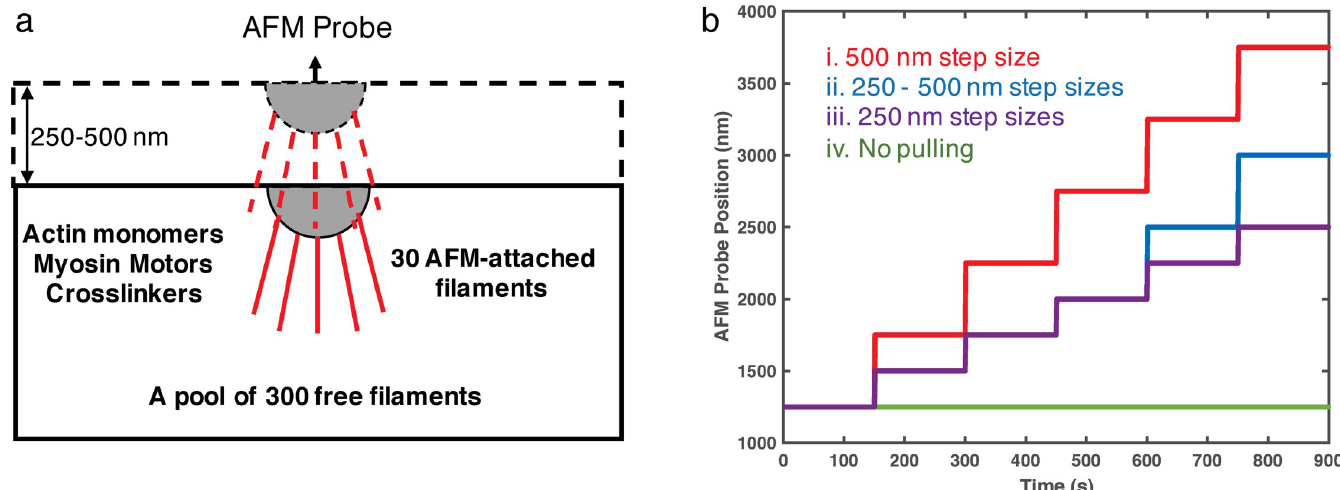
Fig 2. (a) A sketch of the simulation setup. The simulation box is 3 μ m in x and y directions, and the initial height (z-direction) is 1.25 μ m. The simulation box contains 300 free actin filaments, as well as diffusible G-actin, myosin, and α -actinin linkers. A semi-spherical AFM probe is located at the upper boundary, and 30 filaments are attached to the probe via stiff harmonic springs. At the beginning of simulations, all filaments are 0.108 μ m long (containing 40 actin subunits). The input G-actin concentration is much higher than the equilibrium concentration, making actin filaments rapidly elongate. An average length of 0.8 μ m is achieved and maintained after around 40s of simulation. (b) Simulated AFM-probe position, equivalent to the height of upper boundary, as a function of time for Cases i-iii. The control case (Case iv) is without AFM probe and without filament attachment, with only the upper boundary moving in the same way as in Case i to avoid potential boundary effects.